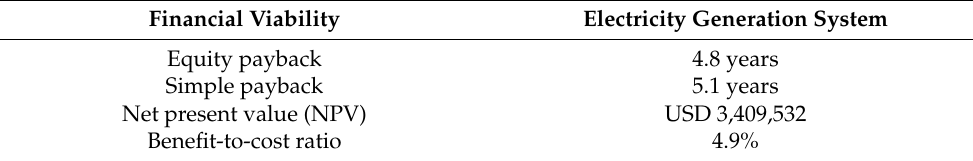
Table 9. Project financial output parameters for an annual electricity rate of 0.2